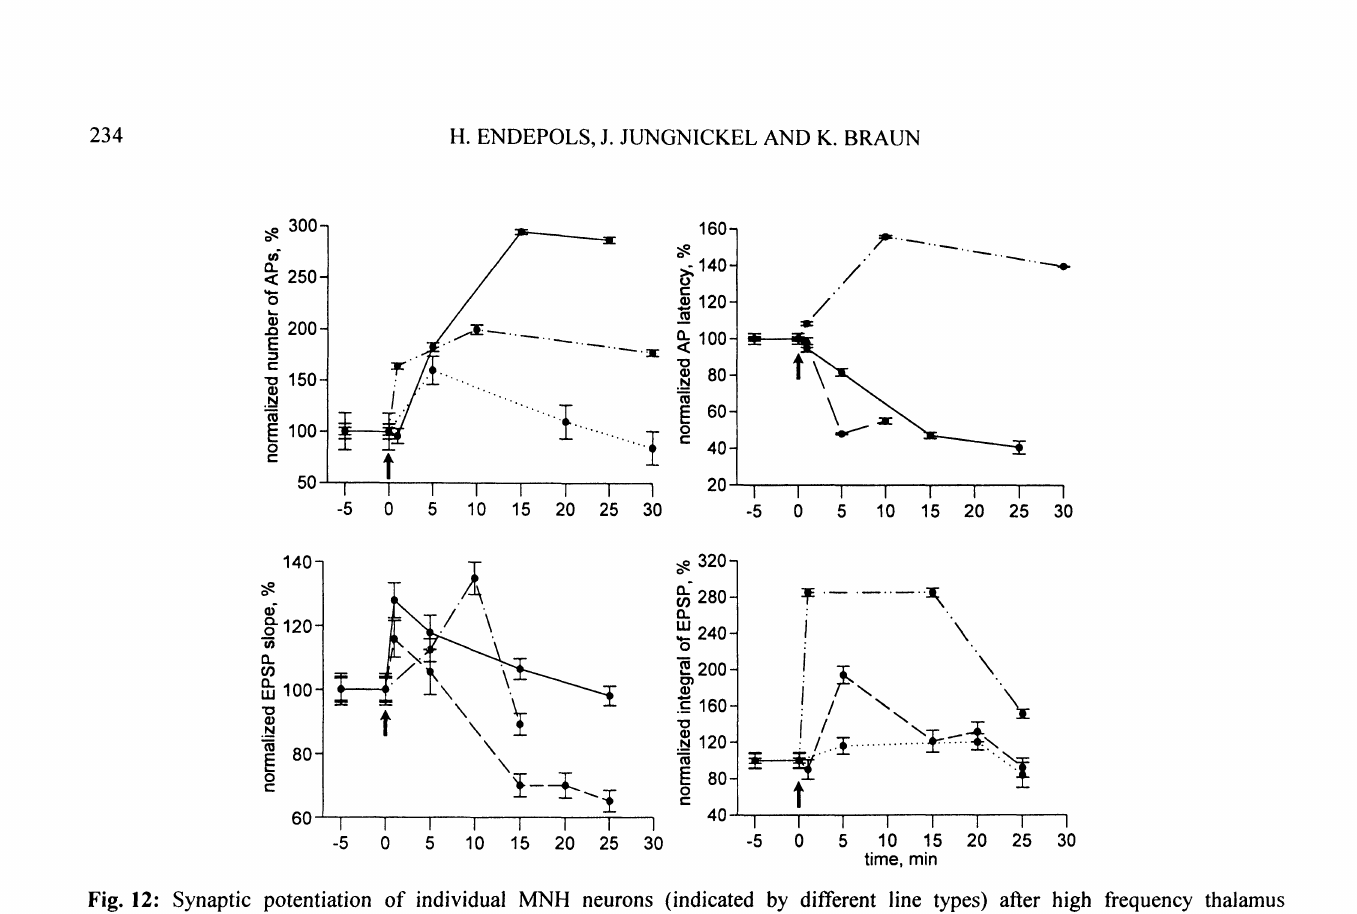
Fig. 12: Synaptic potentiation of individual MNH neurons (indicated by different line types) atter high frequency thalamus stimulation. Mean values and standard errors of the mean were calculated out of 25 recordings, respectively. Arrows indicate high frequency